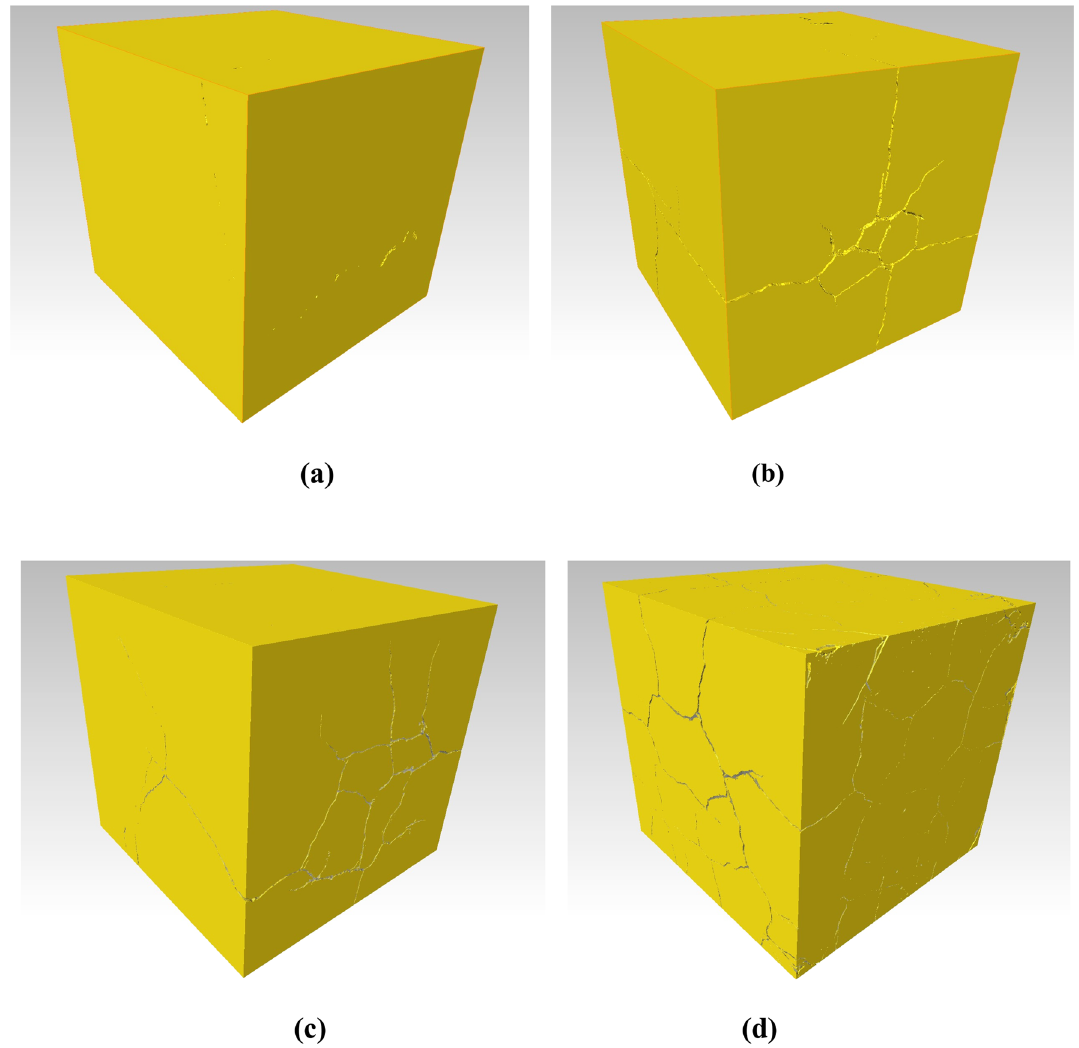
Figure 8. The spatial distribution of bones in the limestone samples after high-temperature treatment: ( a ) 700 °C; ( b ) 800 °C; ( c ) 900 °C; ( d ) 1000